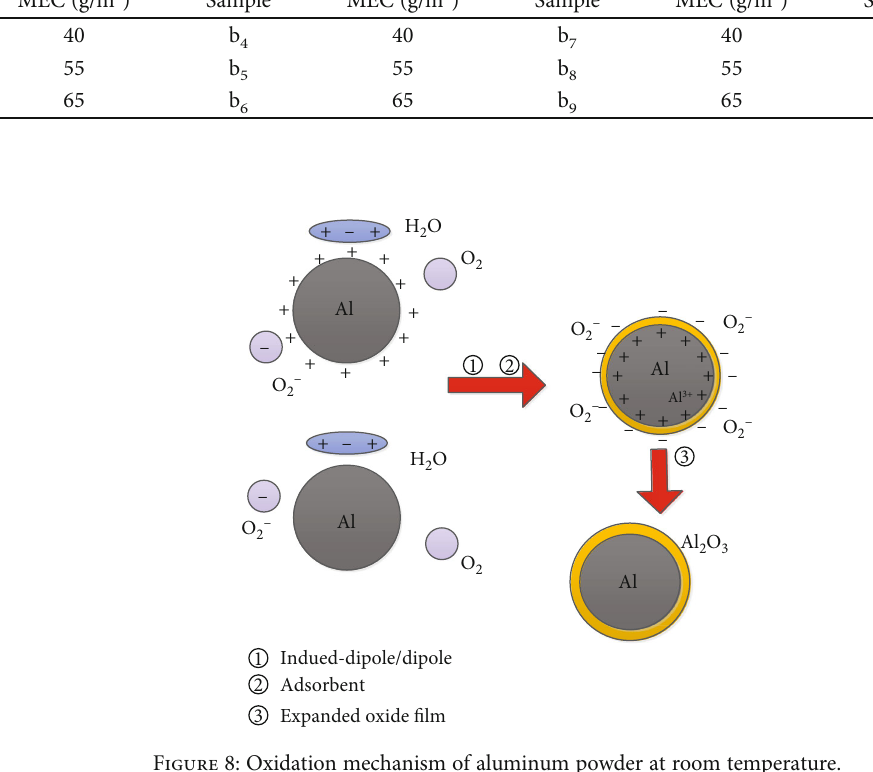
Table 5: Minimum explosible concentration of the aluminum powders with di ff erent moisture contents oxidized for di ff erent periods of time. Sample